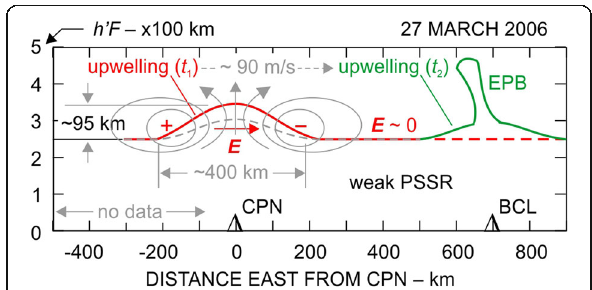
Fig. 15 A sketch showing growth of an upwelling (red curve) over CPN, but not over BCL (red dashed line), at time t 1 , and the arrival of the same upwelling over BCL (green line) at time t 2 . In this sketch, we show (for simplicity) the absence of a PSSR over both CPN and BCL. The separation between CPN and BCL is 6.3° in longitude